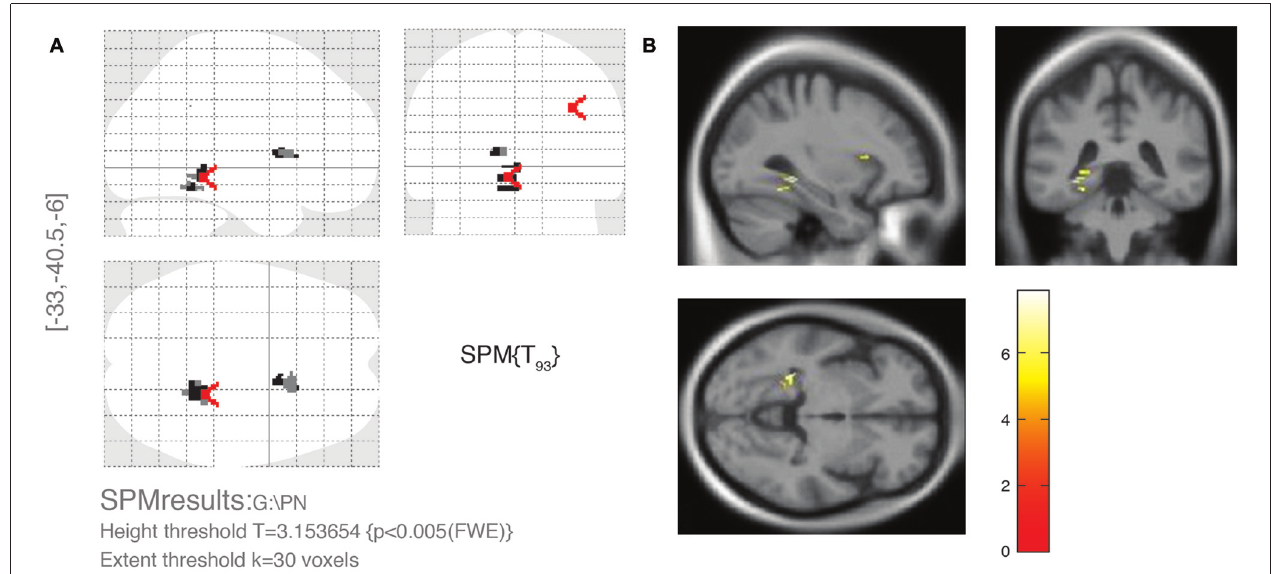
FIGURE 3 | Significant brain area of OPVHs in multivariate regression analyses. (A) SPM results in various brain regions. (B) 3D brain map. GM atrophy was found in the left precentral gyrus and left insula cortex of patients with OPVHs in a multivariate regression analysis ( P < 0.05, FWE-corrected, with 30-voxel clustering